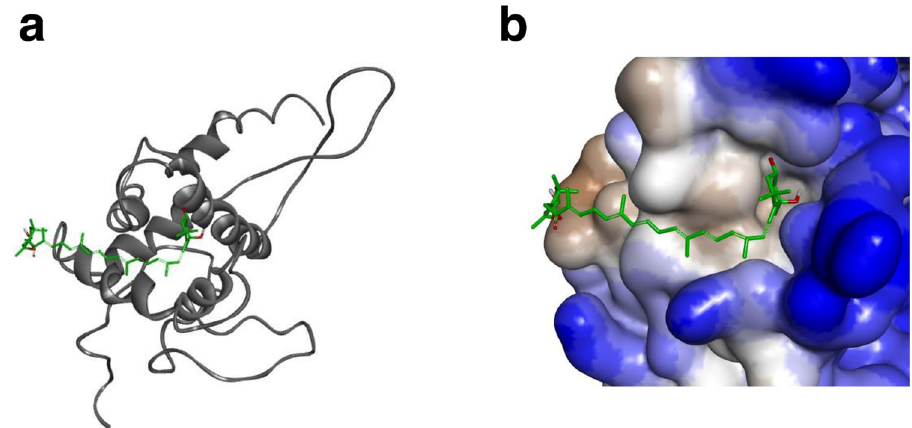
Fig. 3 The molecular binding model for the interaction between uS7 and fucoxanthinol. a The top-ranked pose in the docking simulation. Fucoxanthinol (green stick) and uS7 (gray cartoon) are shown. b Hydrophobicity around the pocket to which fucoxanthinol binds. Brown and blue colors correspond to the hydrophobic and hydrophilic regions of uS7, respectively. Images ( a , b ) were made using BIOVIA Discovery Studio 2018 software (Dassault